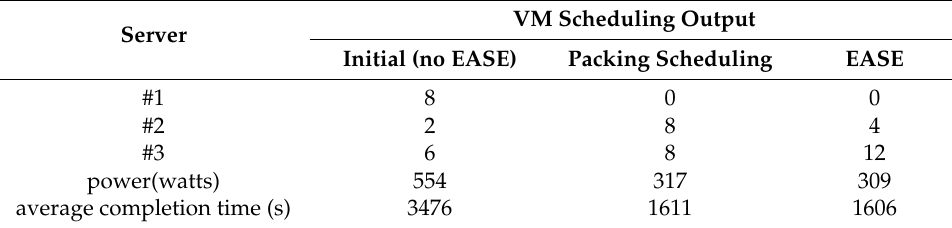
Table 9. Power consumption and performance comparison of heterogeneous cluster.